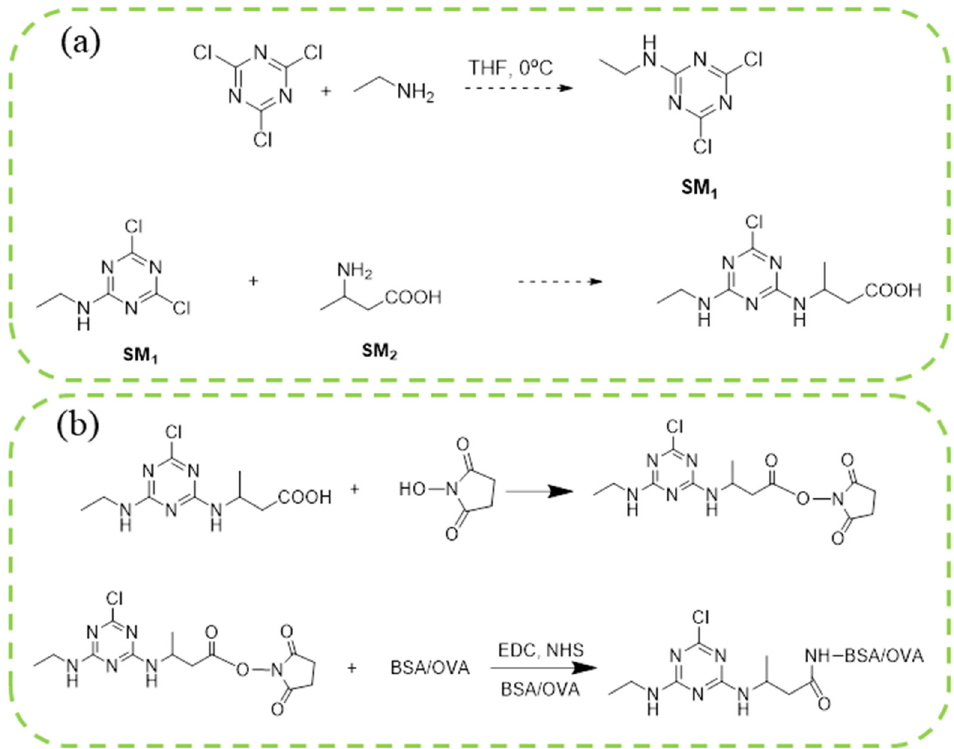
Figure 1. Synthetic routes of hapten ( a ) and immunogen and coating antigen ( b ) of ATR. Immunogenicity was characterized by matrix-assisted laser desorption/ionization time- of-flight mass spectrometry (MALDI-TOF-MS). MALDI-TOF-MS measured the conjugation ratio of the coating antigen and immunogen. This method has the advantages of rapid and straightforward sample preparation and high sensitivity. The matrix auxiliary solution used for the measurement was configured as follows: the mixture (acetonitrile:water = 70:30) contained 0.001% trifluoroacetic acid and erucic acid (15 mg/mL). The wavelength of the Yag excitation light source was 355 nm. The m / z acquisition range was between 10 and 100 kDa. Each sample was mixed with the matrix auxiliary solution. After mixing, spot sample 1 was placed on the sample target of 1 µ L. After natural drying, the sample was placed under a mass spectrometer for Yag laser scanning. The conjugation ratio was calculated as follows: Conjugation ratio = ( M p − M std )/ M h